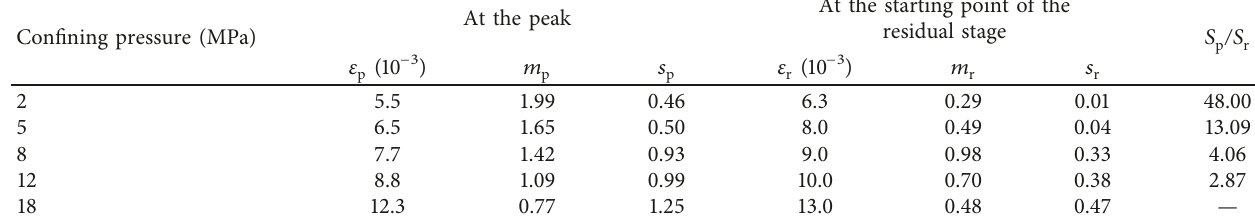
Table 2: Rock strength parameters Confining pressure (MPa)